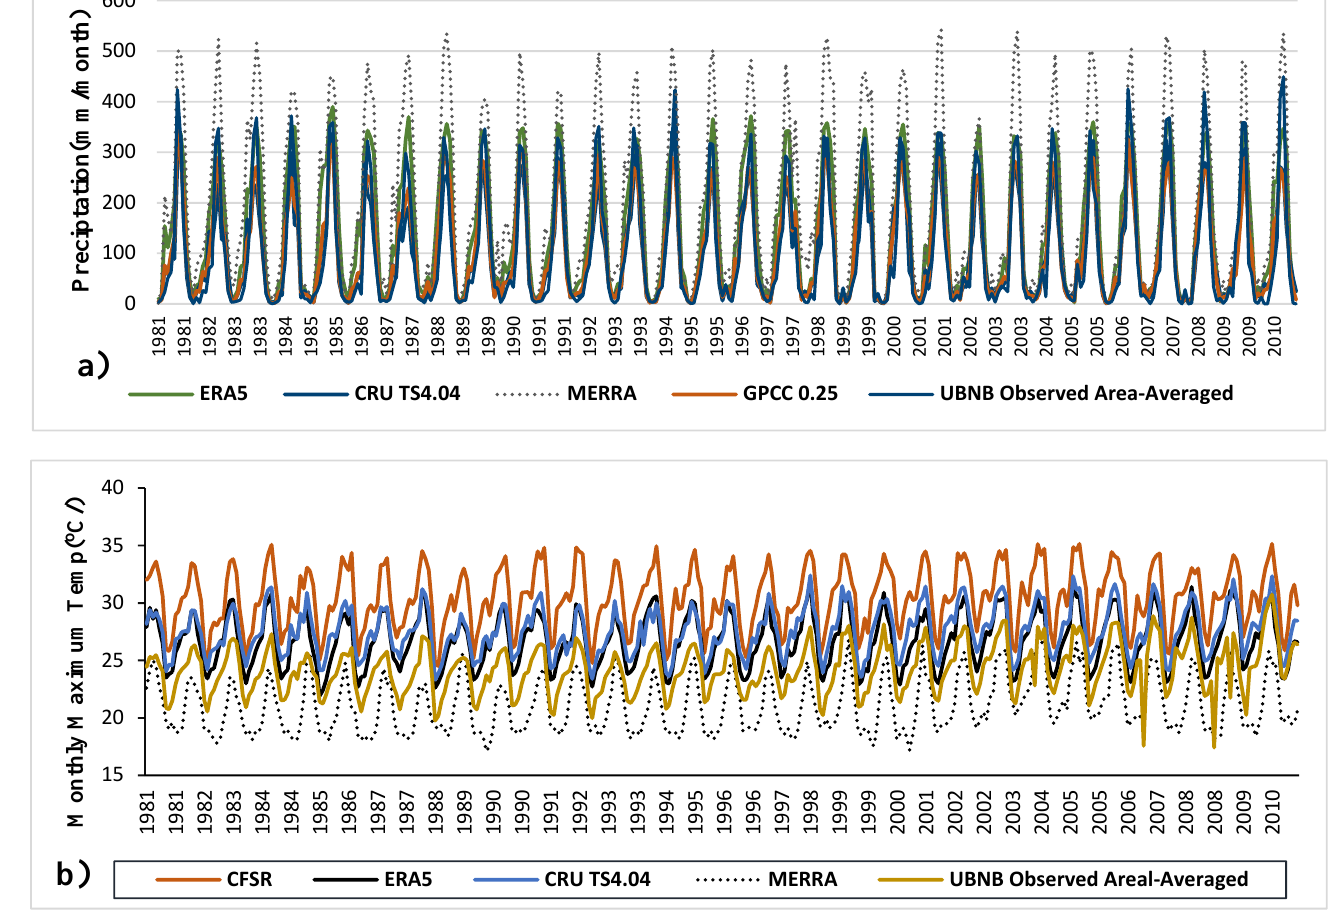
Figure 2. Temporal distribution of monthly observation and reanalysis of ( a ) precipitation (mm/month), ( b ) max. tempera- ture ( ◦ C/month) within the Upper Blue Nile basin